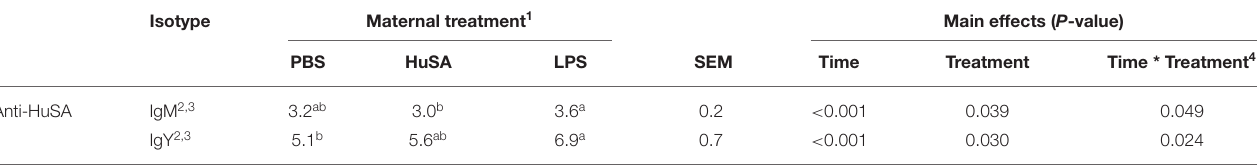
TABLE 1 | Effect of maternal immune activation on HuSA specific IgM and IgY titers during 4 weeks after i.t. immunization of offspring at 4 weeks of age.